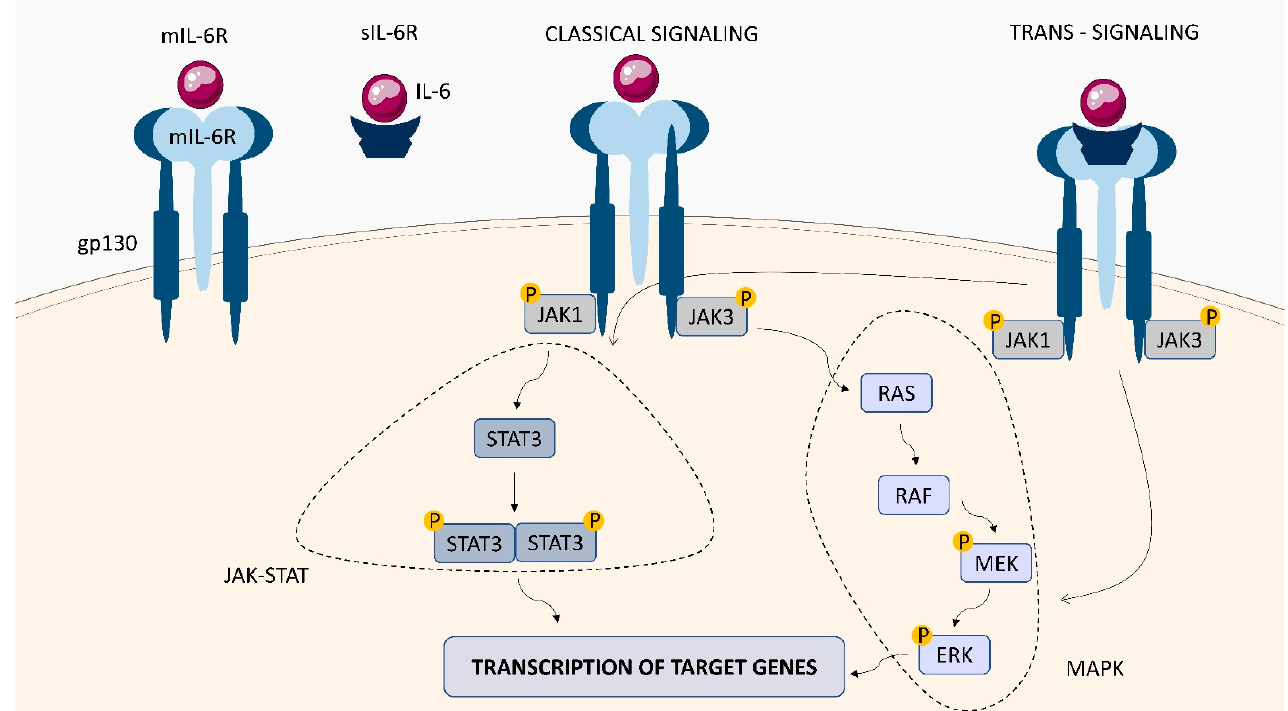
Figure 5. IL-6R structure and signaling. The IL-6-binding receptor complex consists of an IL-6 re- ceptor subunit (IL-6R), existing in both membrane-bound (mIL-6R) and soluble (sIL-6R) forms, and IL-6 signal-transducing chain glycoprotein 130 (gp130). Interaction of IL-6 with IL-6R activates the JAK1 /JAK3 tyrosine kinases. The JAK-STAT and MAPK pathways are activated, which stimulates gene transcription in the cell nucleus, leading to cytokine